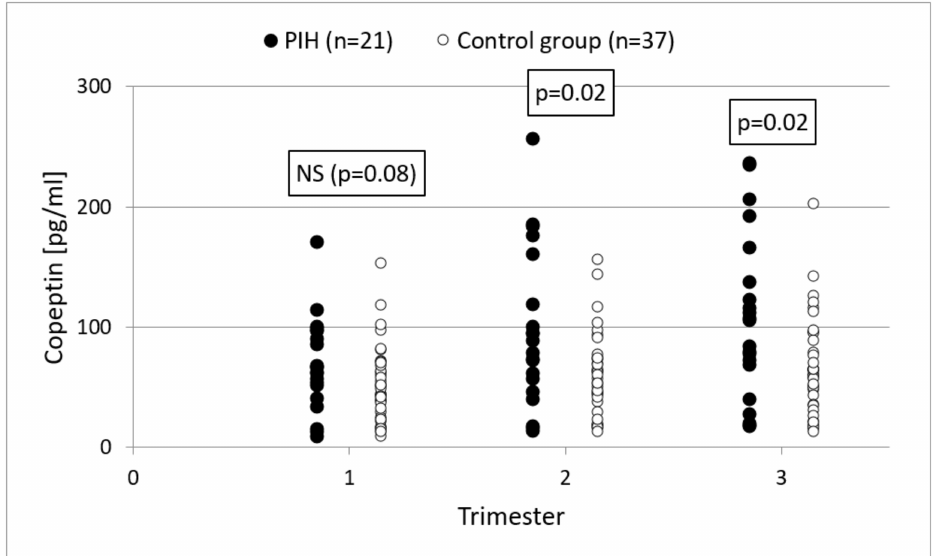
Figure 1. The values of copeptin in the PIH group and in the control group in subsequent trimesters of